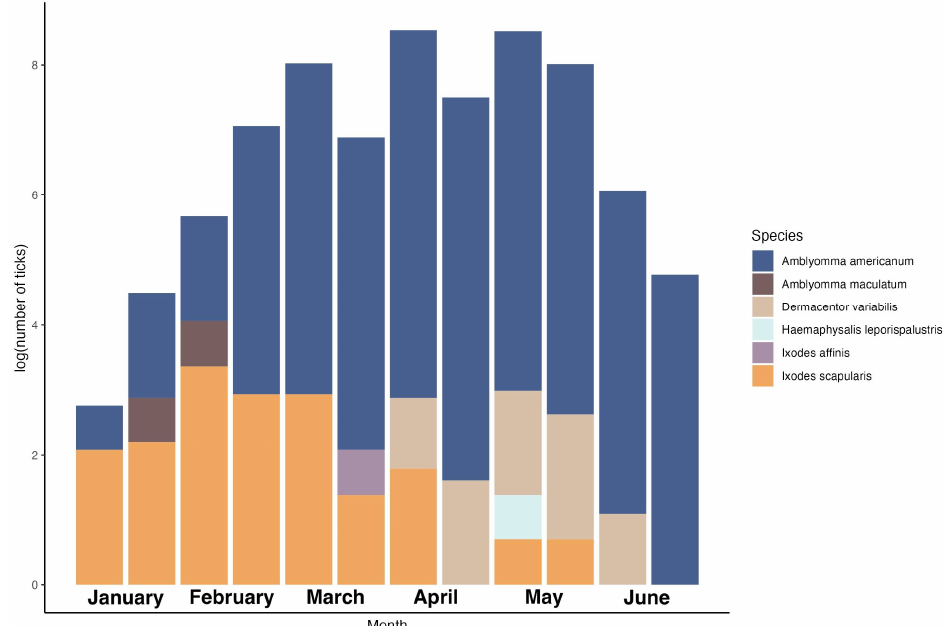
Figure 2. Total number of ticks (log-transformed) by species collected in 17 greenspaces in Alachua County, Florida, USA, per month (two sampling sessions per month), from January to July 2021. Table 1. Average density per 1 km 2 with standard error (SE) of nymphal and adult ticks collected by species, across each sampling bout from the first week of January 2021 to the last week of June 2021 and across location. Estimates are provided for two sampling site categories (9 natural sites and 9 manicured sites) in 17 greenspaces in Alachua County, Florida, USA. Zero indicates no ticks were